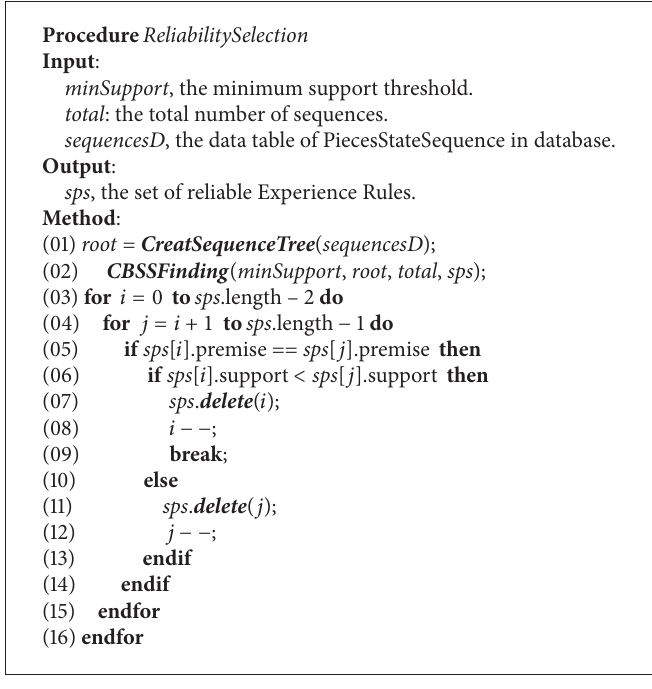
Algorithm 5: ReliabilitySelection